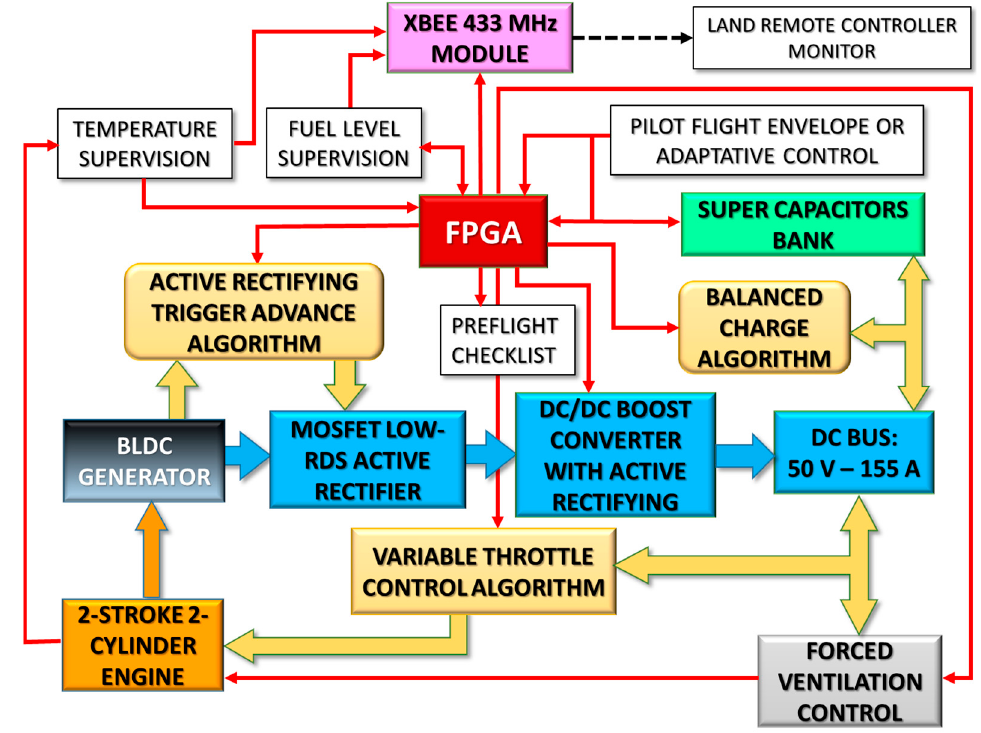
Figure 7. Block diagram of the prototype. Table 3. Prototype general specifications.